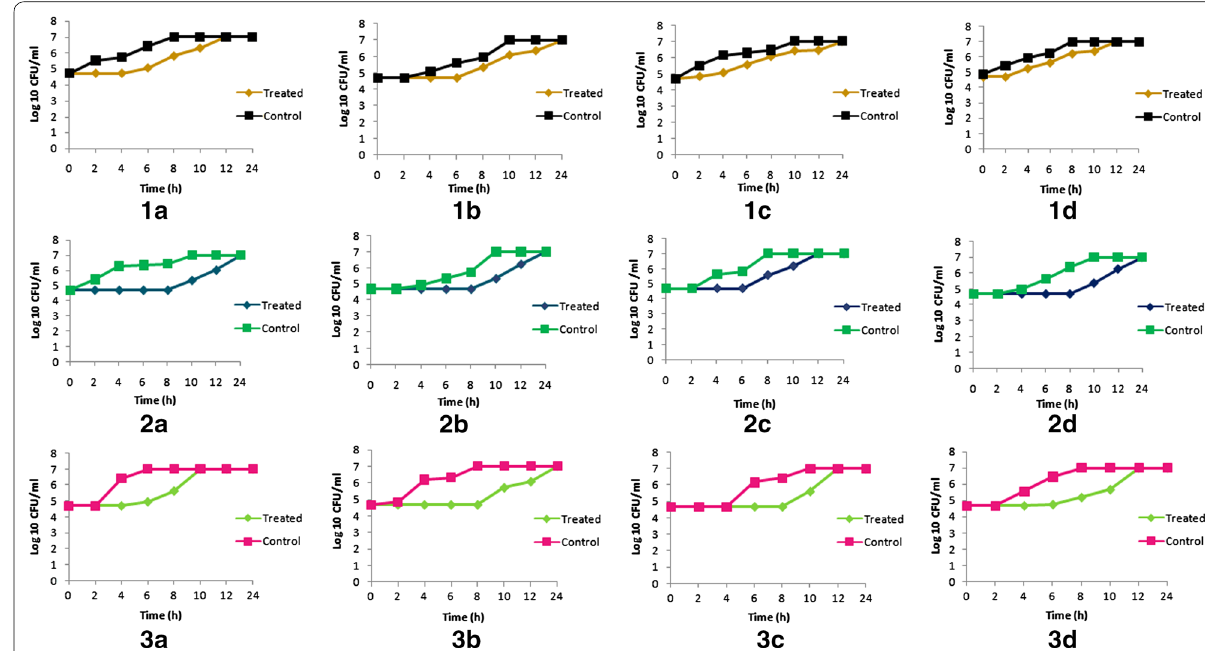
Fig. 3 Post antibiotic effect (PAE) of (1) ethyl acetate extract (2) diterpenes (3) flavonoids of Berberis aristata root bark against ( a ) Staphylococcus